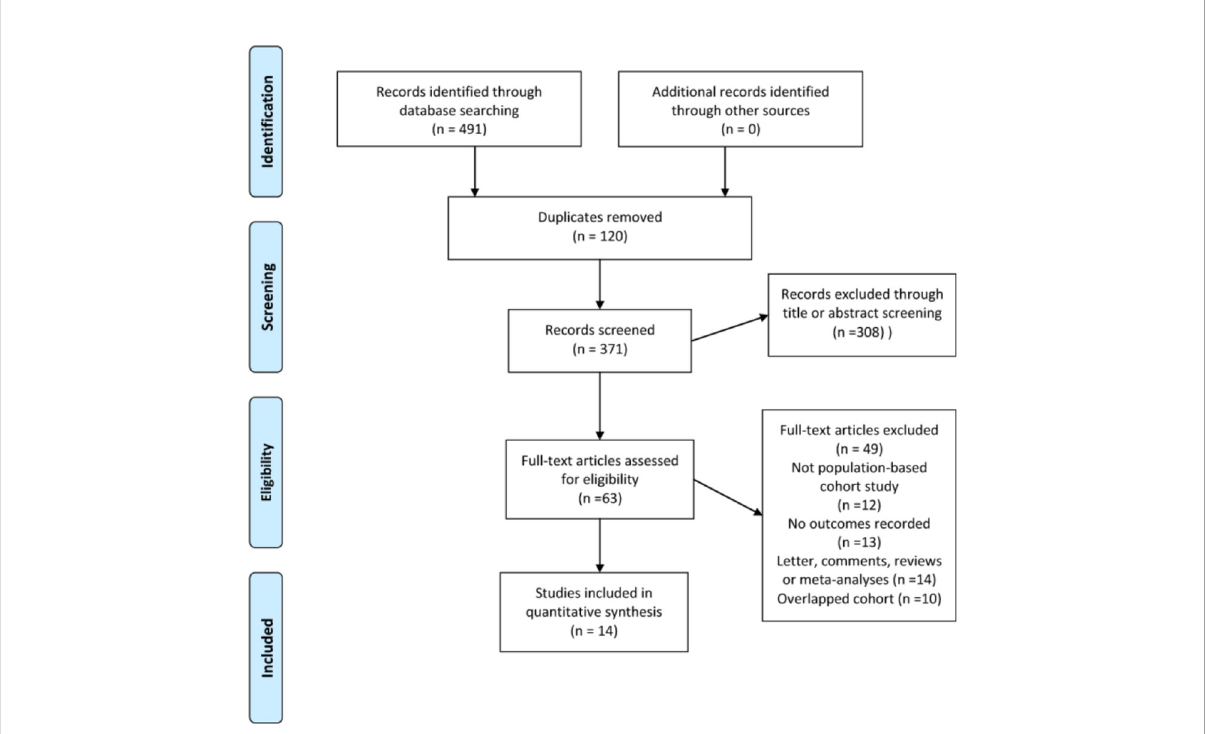
FIGURE 1 Flow diagram of literature screening according to PRISMA and MOOSE